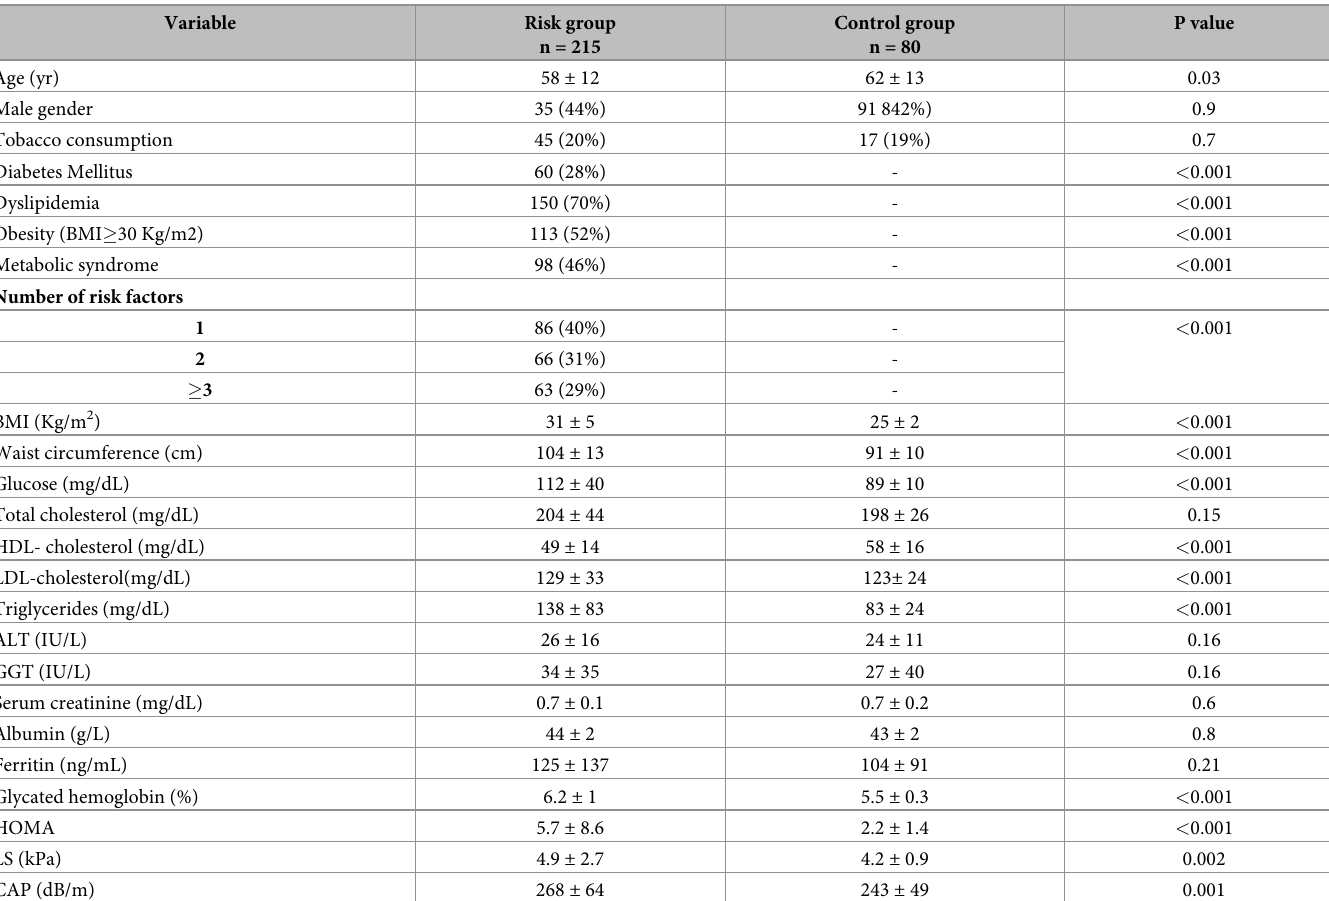
Table 1. Comparison of demographic, clinical, and biochemical data, and liver stiffness and CAP of subjects from the risk group and control group.